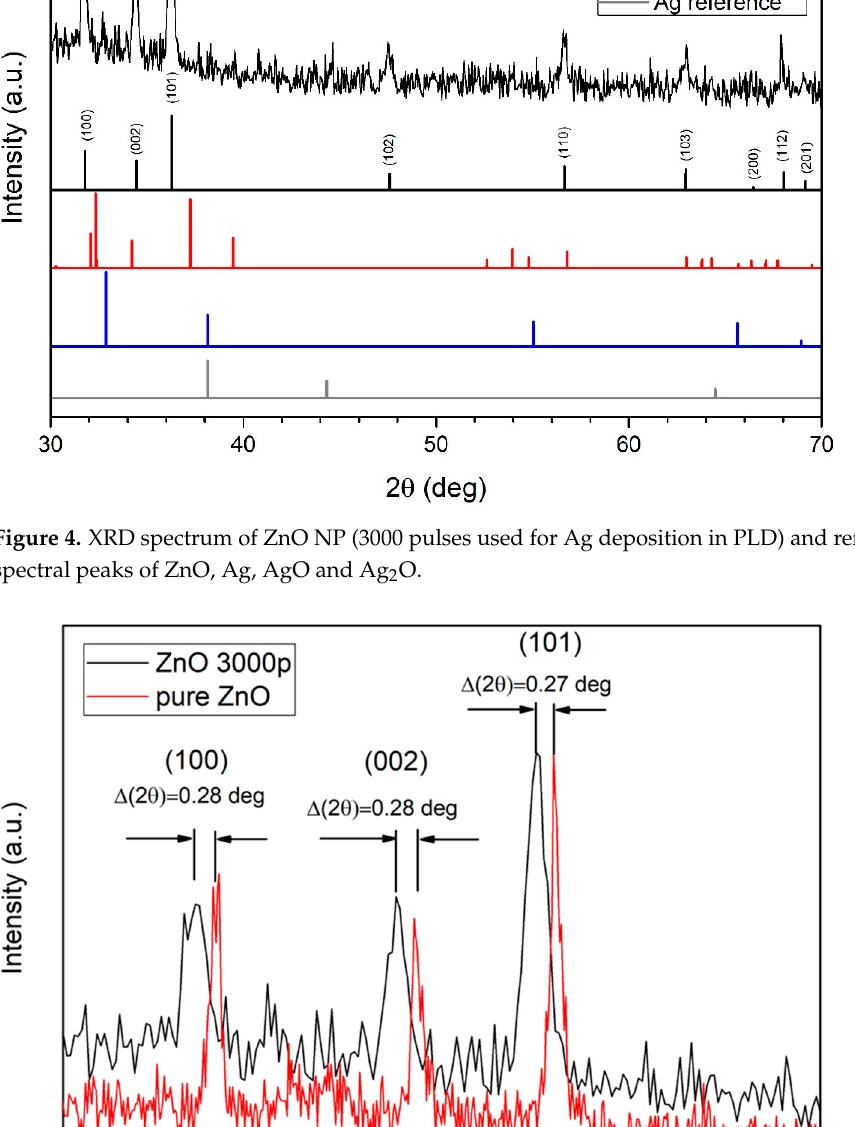
Figure 5. The shift of Ag-doped ZnO XRD peaks, with respect to the pure ZnO peaks. The XRD peaks of the Ag-doped ZnO NPs shifted to a lower 2 θ angle value, as com- pared with those of pure ZnO nanoparticles. This shift appears due to the fact that the radius of the incorporated Ag + ions is greater than that of Zn 2+ , which consequently causes lattice expansion [35]. The FWHM of the pure ZnO diffraction peaks is narrower than the Ag-doped ZnO peaks, implying that the doping causes the formation of smaller crystallites [36]. The average crystallite size ( D ) was calculated using Debye–Scherrer’s formula [37], using data from the pure and Ag-doped ZnO main XRD